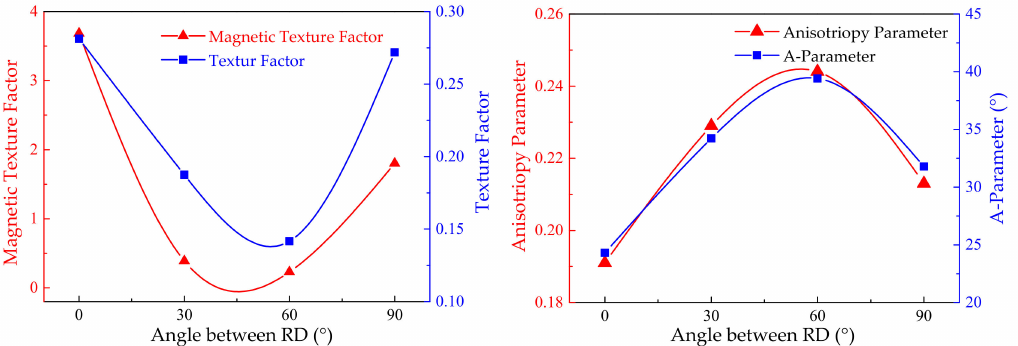
Figure 9. Variation trend of Texture Factor, Magnetic Texture Factor, A-parameter and magnetic → h ) of Fe-0.65%Si non-oriented electrical steel annealed sheet. anisotropy parameter A (